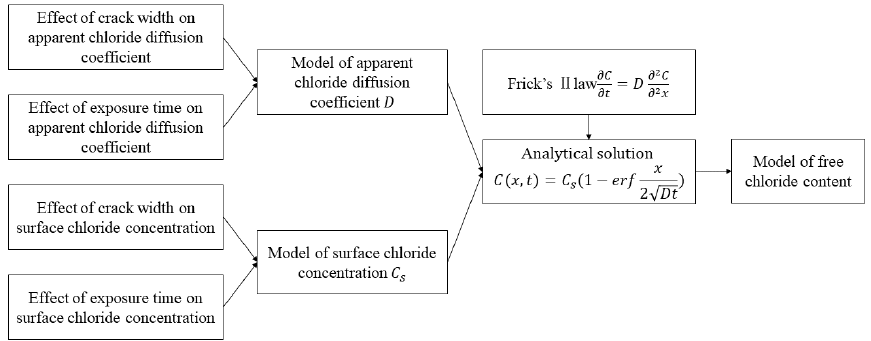
Figure 3. Development of the model of chloride transportation in ECC.